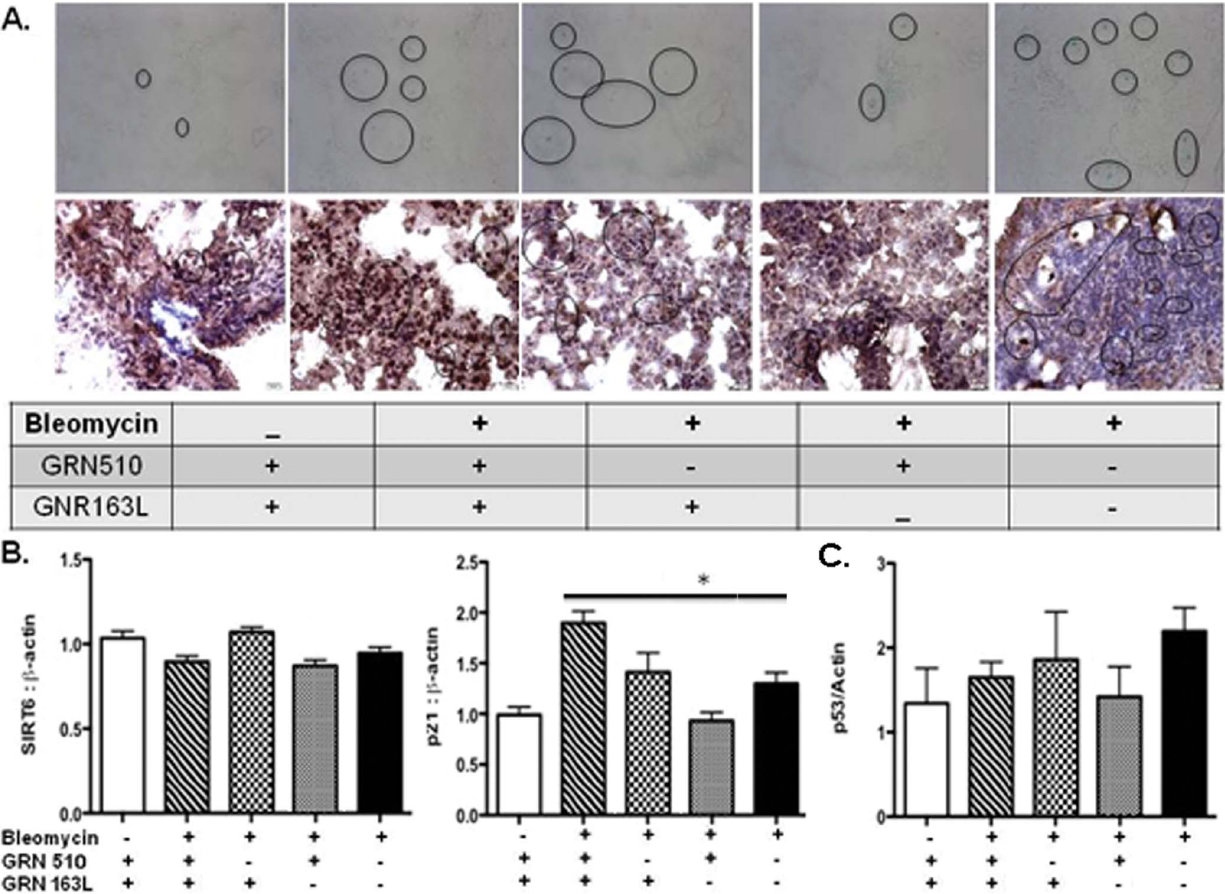
Figure 5. Reduced cellular senescence in bleomycin-injured lung tissue with GRN510 treatment. All analyses were performed on the same mice as in Fig. 4. A. Analysis of SA- b galactosidase activity in the lung tissue. Shown are representative paraffin-embedded lung sections after staining for SA- b gal activity (blue staining). Increased SA- b gal activity was detected in the mice challenged with bleomycin and treated with vehicle or GRN510 and GRN163L. In contrast, reduced SA- b gal activity was detected in the mice challenged with bleomycin and treated with GRN510. Positive stained cells are encircled. Magnification 40X. Representative paraffin embedded lung sections immunohistochemically stained for MH2A using enhance blank staining solution (KPL, Gaithersburg, MD); n=3 different specimens with 3 fields of view analyzed per section; Hematoxylin was used as a negative counter-stain. Magnification of 40X. Circles denote positive staining. B. Analysis of SIRT6 and p21 expression in the lung. Targeted genes and b -actin expression at the mRNA level was determined by qRT-PCR. Analysis was performed in triplicate for each specimen. N=5–10 animals per group. Asterisk, * indicates significance amongst indicated groups (P=0.002, 1-way ANOVA). C. Western analysis of p53 expression. A trend in increase expression was associated with bleomycin treatment that was partially reverted by GRN510 treatment. For all plots mean 6 SEM is shown.